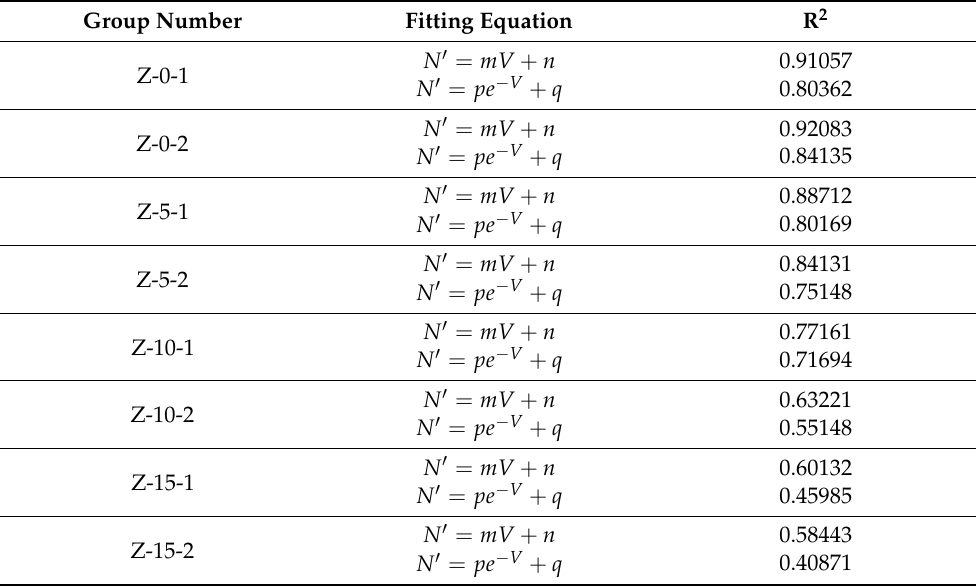
Table 2. Fitting results of the